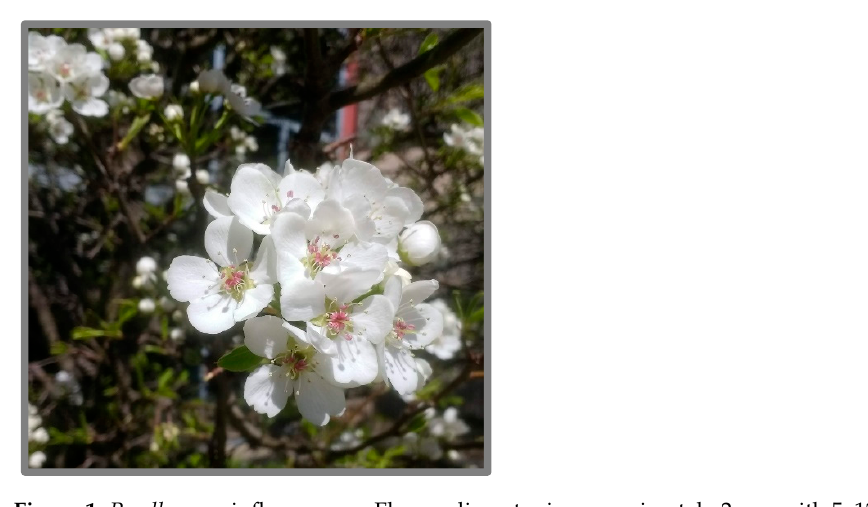
Figure 1. P. calleryana inflorescence. Flower diameter is approximately 2 cm, with 5–12 flowers per inflorescence. Ben Dolan, University of Findlay.